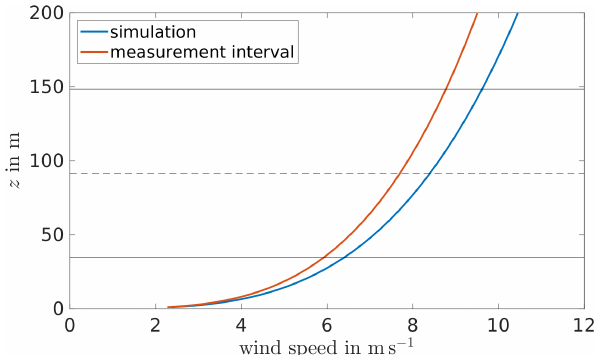
Figure C1. Wind profiles, calculated by the shear and wind speed, of the measurement interval and the simulation data used in the comparison of the loads for the stable case. The black lines indi- cate the rotor area, and the dashed line indicates the hub